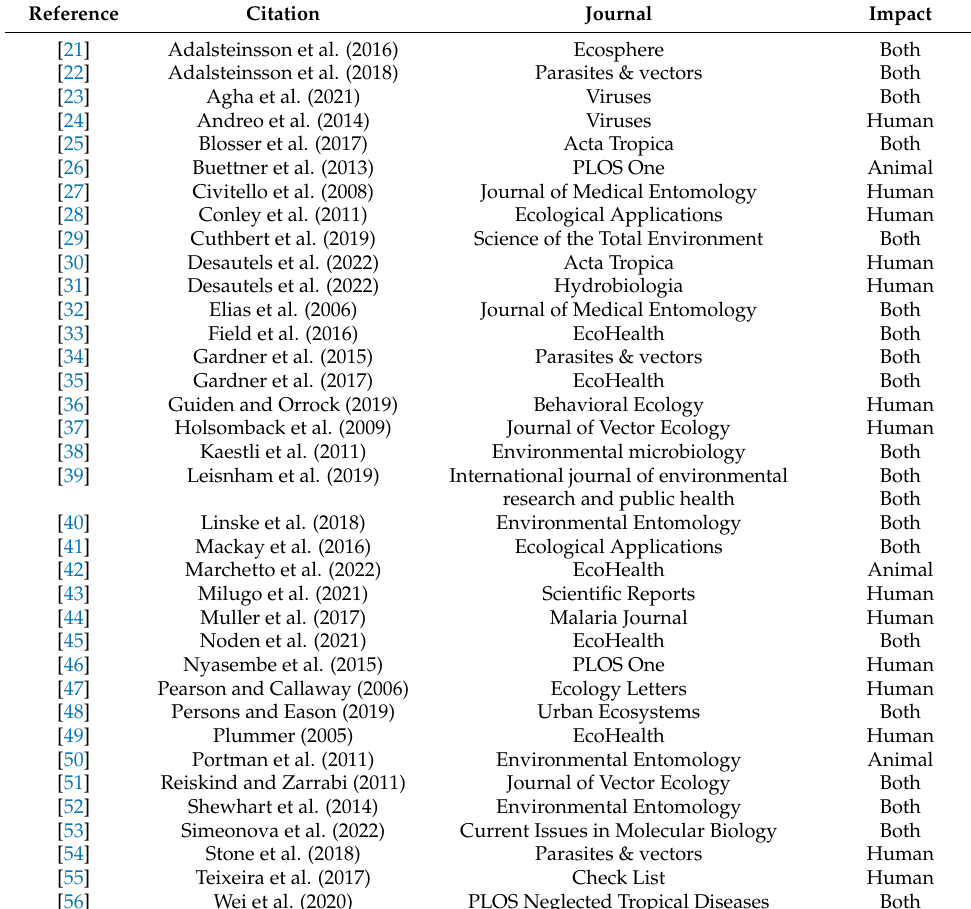
Table 1. List of reviewed articles and their impact target, in health terms.